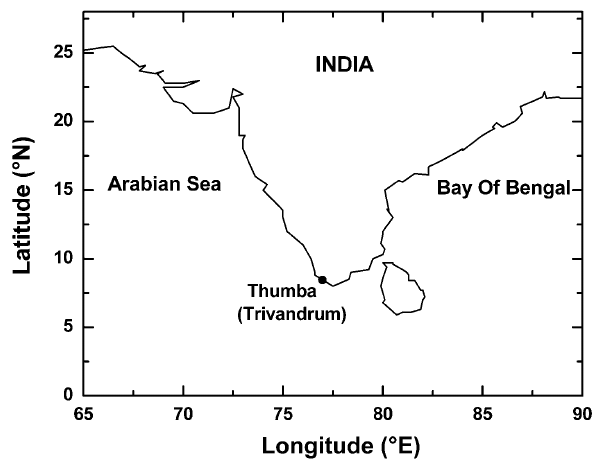
Figure 1. Location map of the observation site Fig. 1. Location map of the observation